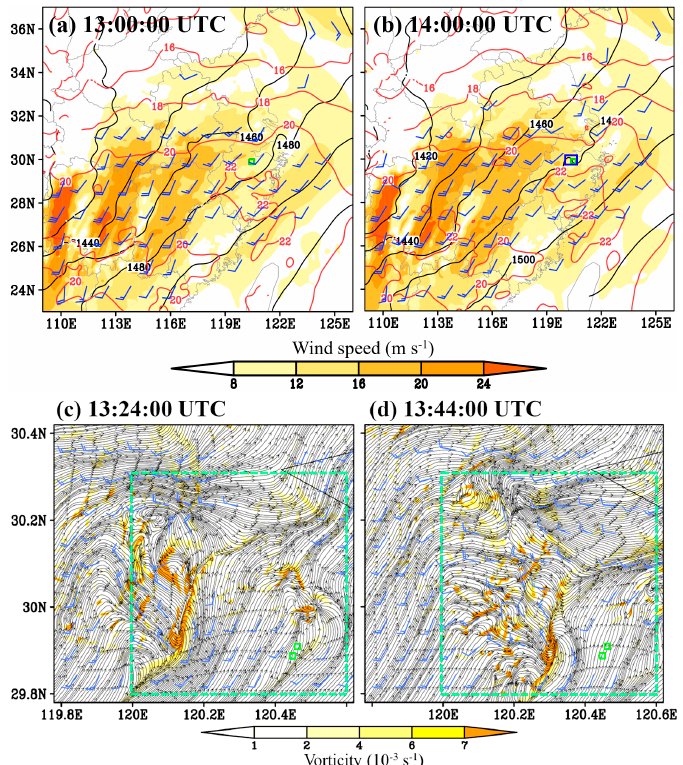
Figure 9. Panels ( a , b ) show the geopotential height (black contour; gpm), temperature (red contour; °C), wind speed (shading; m s − 1 ), and wind above 8 m s − 1 (a full bar is 10 m s − 1 ) at 850 hPa, where the small green boxes mark the locations at which the tower toppling appeared and the small blue box shows the key region. Panels ( c , d ) show the 850 hPa stream field, vorticity (shading; 10 − 3 s − 1 ) and wind above 10 m s − 1 (a full bar is 10 m s − 1 ), where the small green boxes mark the locations at which the tower toppling appeared and the green dashed boxes show the key region.